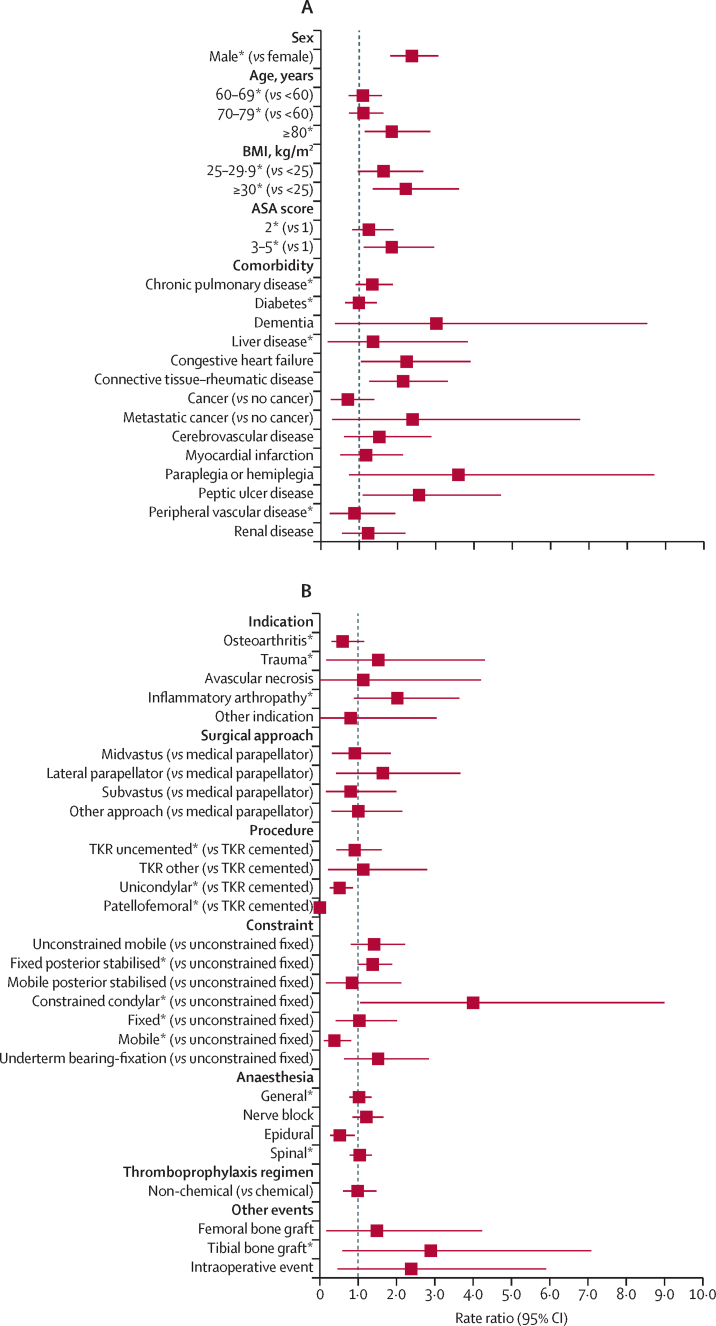
Risk factors of revision for prosthetic joint infection in the first 3 postoperative months(A) Patient factors. (B) Surgery factors. (C) Health-care system factors. Reference categories are in parentheses. BMI=body mass index. ASA=American Society of Anesthesiologists. TKR=total knee replacement. NHS=National Health Service. *Adjusted p value <0·05, detailed in appendix pp 10–12, alongside the rate ratios and 95% CIs. †Volume refers to the total volume of knee replacements performed within the previous 12 months.